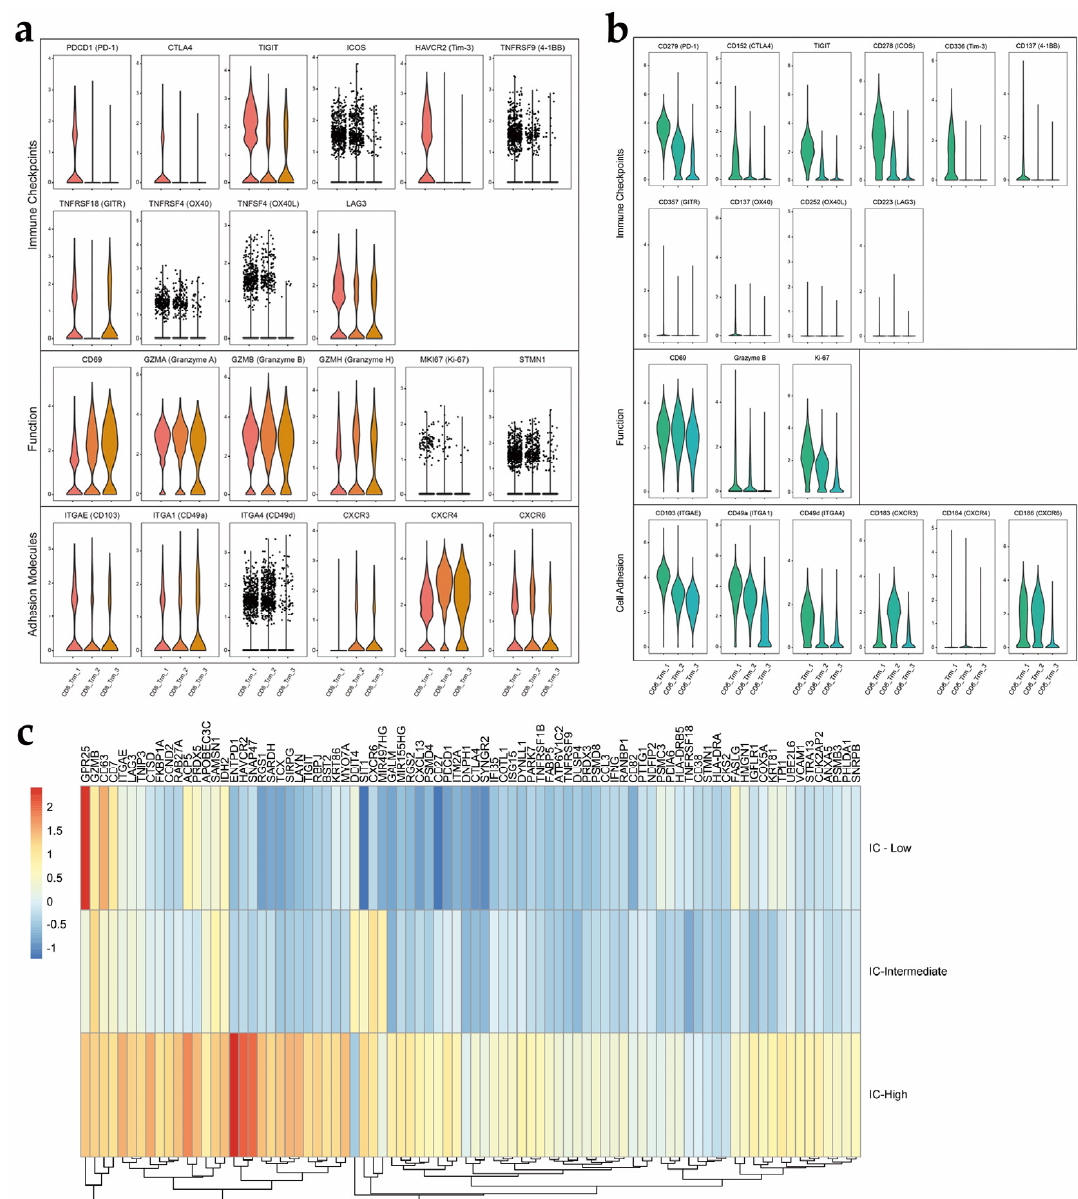
Figure 6. T RM cell subsets in EC show heterogeneity. ( a ) Expression levels of selected markers in T RM cell subsets (scRNA-seq); ( b ) Expression levels of selected markers in T RM cell subsets (mass cytometry). Expression levels of the group of genes that represent immune checkpoint- and cell function (cytotoxicity)-related molecules and adhesion molecules shown in ( a , b ); ( c ) Heatmaps comparing genes in TRM subsets. TRM cells were divided into three subsets according to immune checkpoint molecule expression.